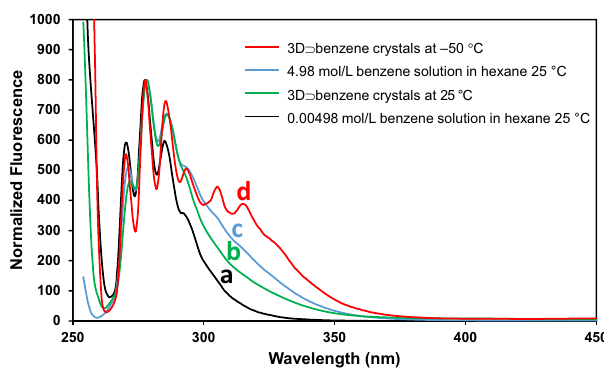
Fig. 5 Fluorescence spectra at room temperature ( λ excitation = 254 nm), normalized using the peak at 278.6 nm. The background corrections of all the emission and excitation spectra were performed using a 5.5g/L solution of rhodamine B in ethylene glycol (200 – 400nm) and a halogen lamp (JASCO ESC-842, 20W, 400 – 850nm). A 0.00498mol/L benzene solution in hexane at 25°C (a), 3D ⊃ benzene crystals at 25°C (b), 4.98mol/L benzene solution in